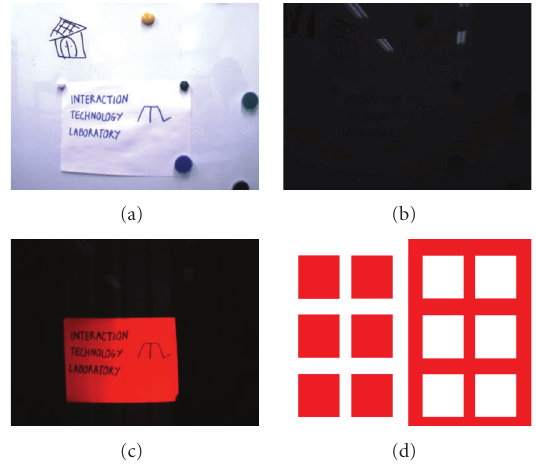
Figure 4: (a) is an environment seen by a camera with normal shut- ter settings. (b) is the environment (a) as seen by the synchronized camera. (c) is the environment (a) seen by the synchronized camera when image (d) is being projected from the DLP projector.